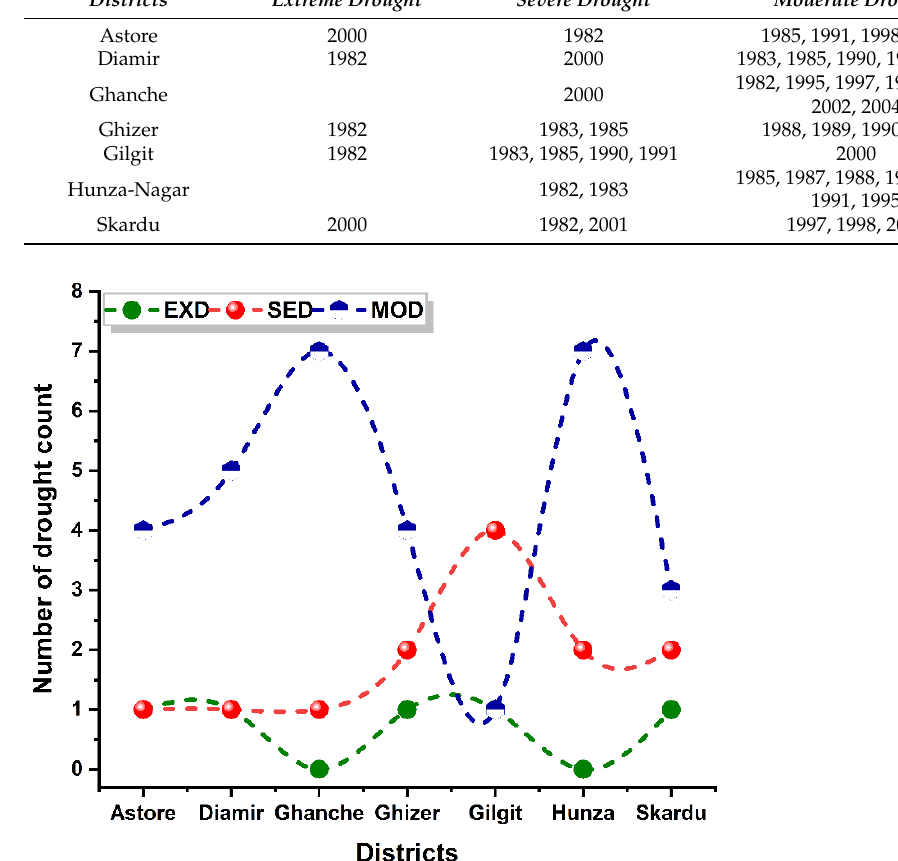
Figure 3. Frequency of drought at 12-month time scale. Table 5. Frequency of drought for 12-Month SPI